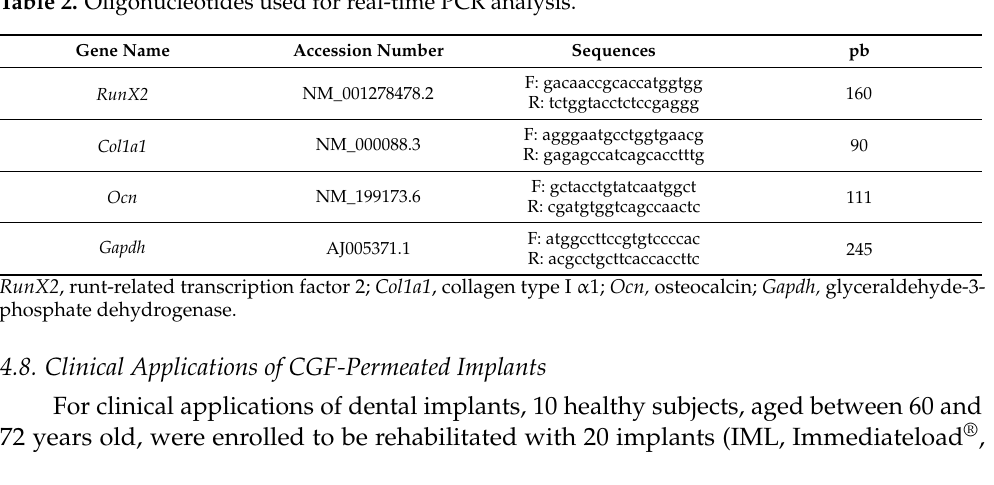
Table 2. Oligonucleotides used for real-time PCR